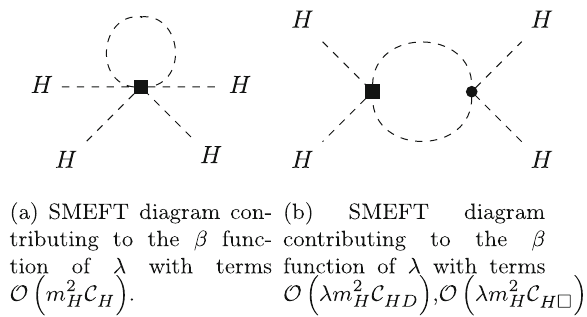
Fig. 1 Two SMEFT diagrams that contribute to the running of the Higgs quartic coupling λ . The solid square denotes a SMEFT vertex and the dot denotes a SM vertex 8 classes, depending on their field content, which